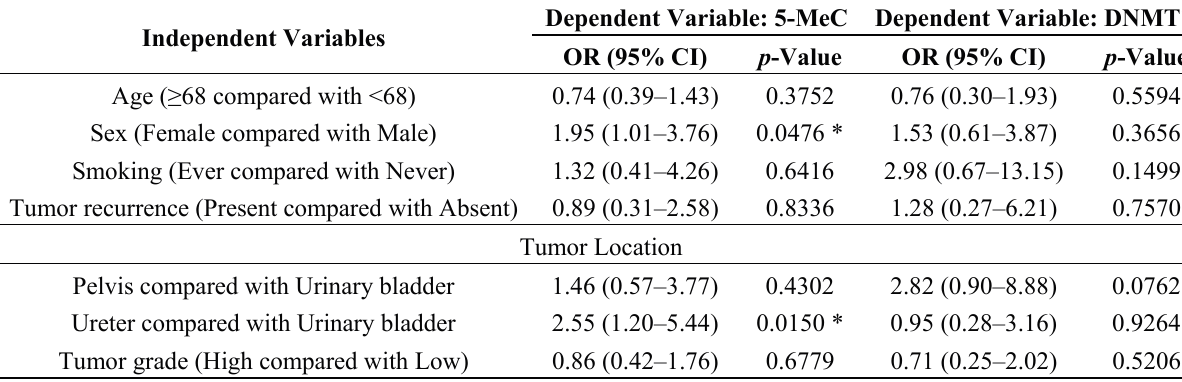
Table 4. Significant factors associated with UCs with low 5-MeC or low DNMT1